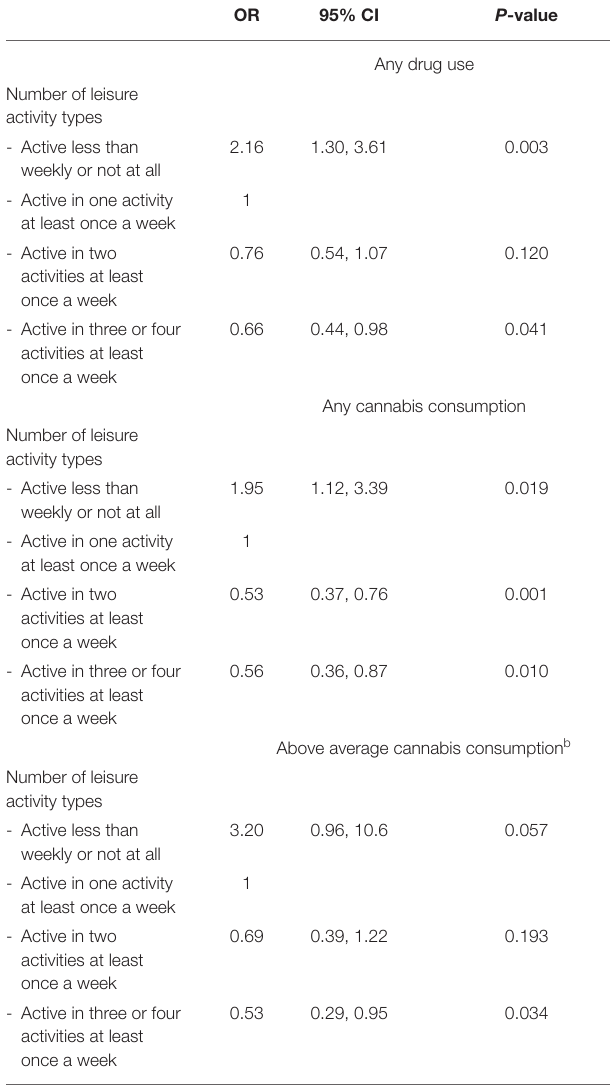
TABLE 6 | The association between number of leisure activity types and drug use or cannabis consumption estimated by multivariable logistic regression. OR 95% CI P -value Any drug